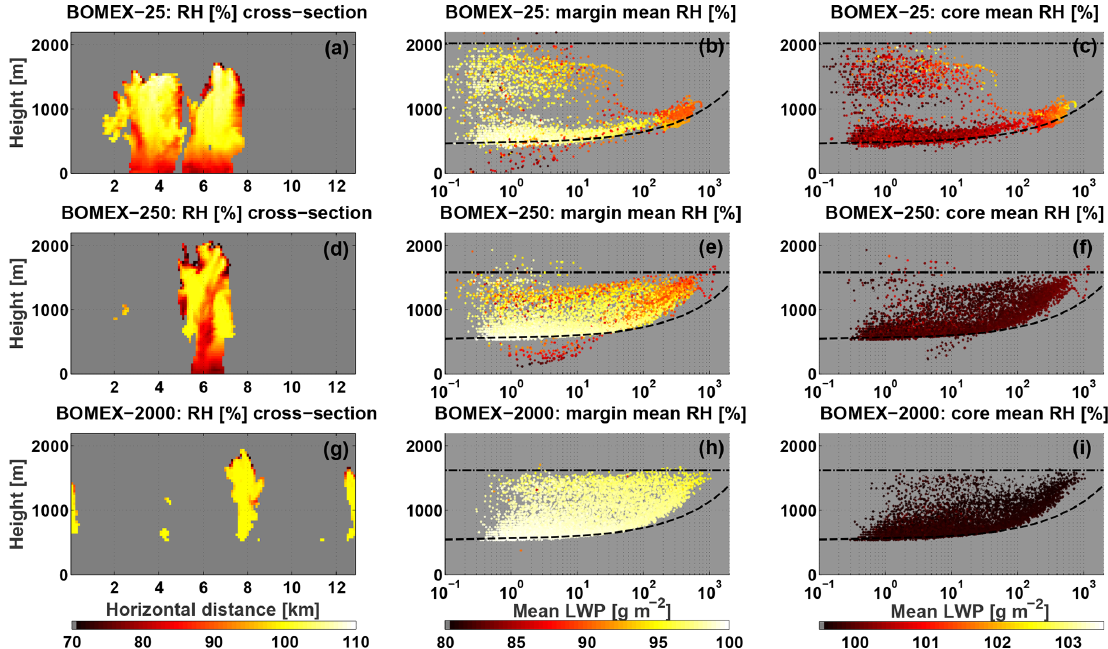
Figure 9. (a, g, g) Relative humidity (RH; %) vertical cross-sections slicing through the center of gravity of the most massive cloud in each simulation. (b, e, h) and (c, f, i) display CvM space diagrams of mean cloud margin RH and mean cloud core RH, respectively, using the RH core definition. The upper (a, b, c) , middle (d, e, f) , and lower (g, h, i) panels correspond to the clean, intermediate, and polluted aerosol cases. Notice that the different color bar ranges for margin and core mean RH